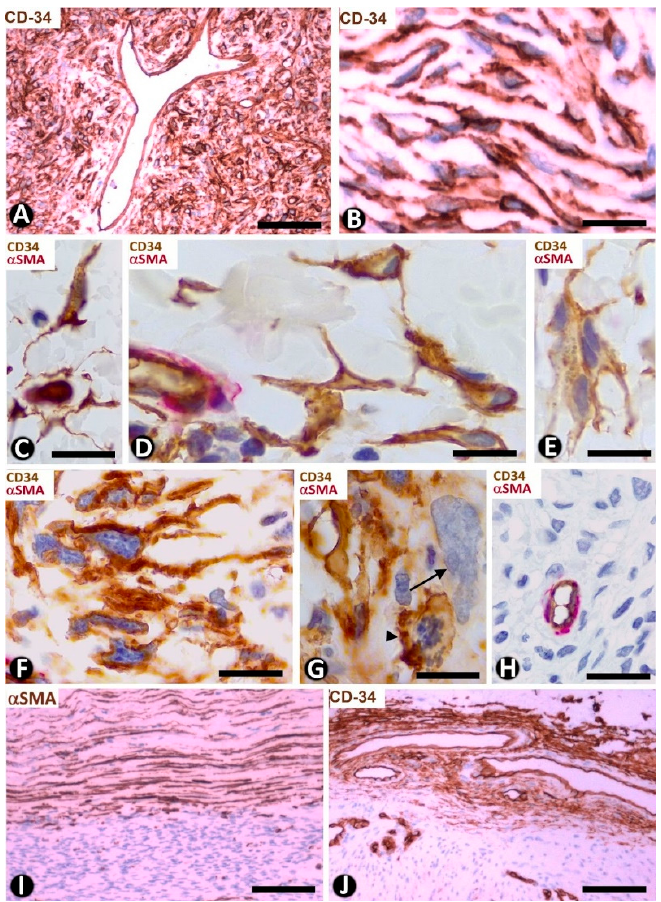
Figure 14. CD34+ stromal cells in a solitary fibrous tumor ( A , B ), fibroepithelial polyp ( C – E ), myxofibrosarcoma ( F – H ) and capsules in a solitary fibrous tumor ( I ) and in myopericytoma ( J ). ( A , B , J ) Immunochemistry for CD34 (brown). Hematoxylin counterstain. ( C – H ) Double immuno- chemistry for CD34 (brown) and α SMA (red). ( I ): Immunochemistry for α SMA (brown). Hematoxylin counterstain. ( A , B ): Stromal cells expressing CD34 in a solitary fibrous tumor. ( C – E ) Spindled and pleomorphic CD34+ stromal cells in fibroepithelial polyps. Note in ( E ) a CD34+ multinucleated stromal cell. ( F – H ) Stromal cells expressing CD34 or not in myxofibrosarcoma. Note in ( F ) long processes in the CD34+ stromal cells, in ( G ) a CD34+ stromal cell in mitosis (arrowhead) and another pleomorphic cell with scarce expression of CD34 (arrow), and in ( H ) absence of CD34 expression. ( I , J ) Capsules of a solitary fibrous tumor with stromal cells expressing α SMA ( I ) and in a myopericy- toma with stromal cells expressing CD34 ( J ). Bar: ( A , I , J ) 80 µ m, ( B – G ) 25 µ m, ( H ) 45 µ